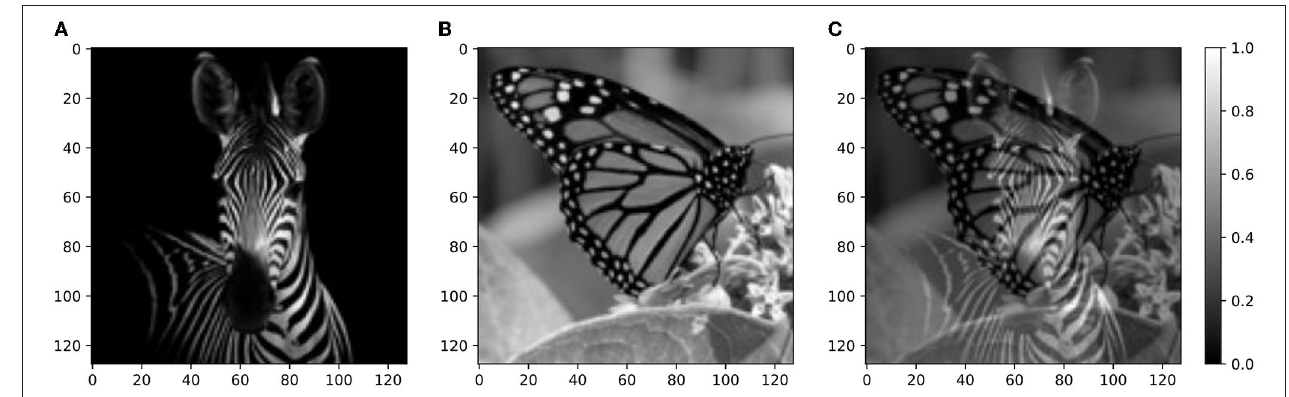
FIGURE 9 | Real-world images—targets and mixture. (A) Squared 128 × 128 target image of a zebra. (B) Squared 128 × 128 distractor image of a butterfly. (C) Mixture of the target and distractor images shown in (A,B) . Source: